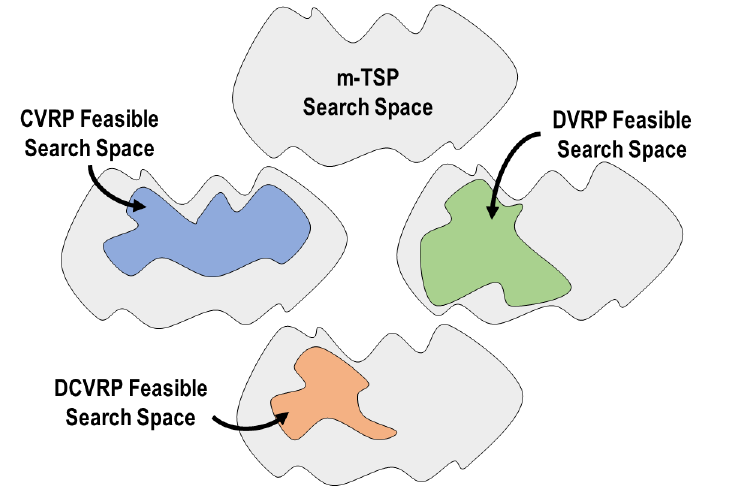
Figure 1. Relation between the VRP variants considered in this